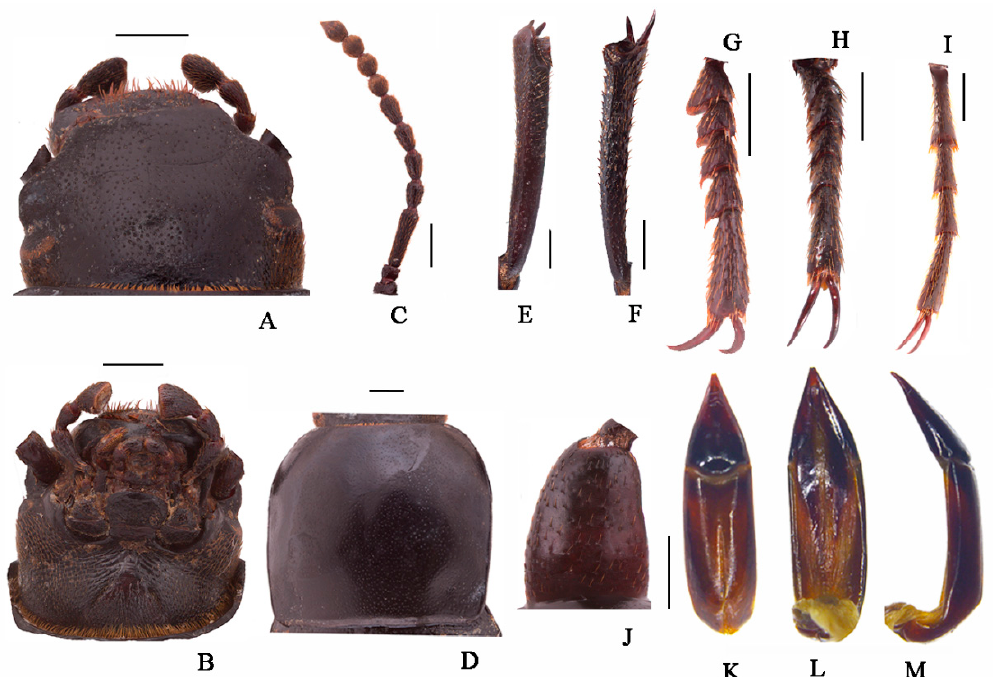
Figure 6. Nalepa polita Li & Ren sp. n. ( A ) head, dorsal view; ( B ) head, ventral view; ( C ) antenna; ( D ) pronotum; ( E ) protibia; ( F ) mesotibia; ( G ) protarsus; ( H ) mesotarsus; ( I ) metatarsus; ( J ) profemora; ( K – M ) aedeagus: ( K ) dorsal view; ( L ) ventral view; ( M ) lateral view. Scale bars: ( A – J ) (1.0 mm), ( K – M ) (1.0 mm); from Chowa, Dêgê, Sichuan, China.